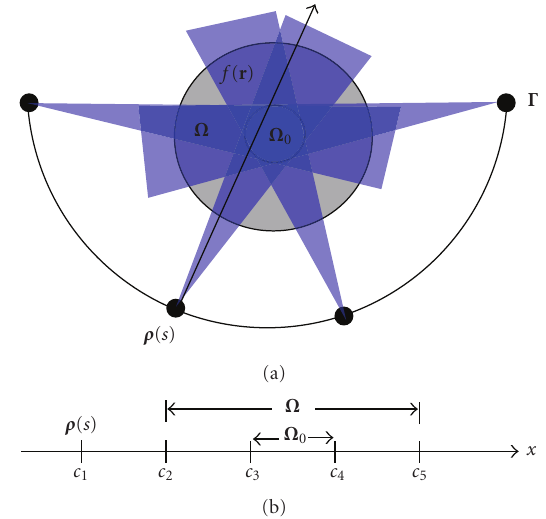
Figure 4: (a) Illustration of the subregion/volume half-scan ROI problem; (b) the 1D coordinate system along the X-ray path indicated in (a).